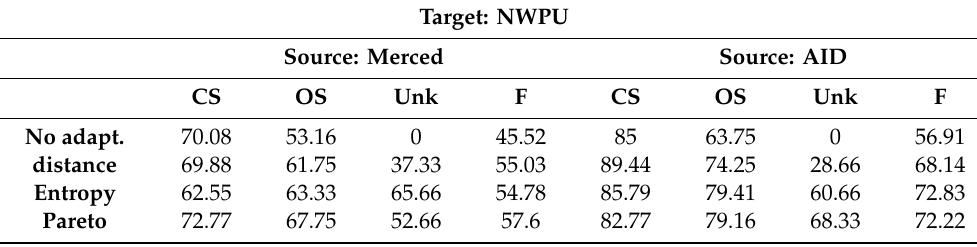
Table 3. Classification results obtained for the scenarios: Merced → NWPU and AID → NWPU for an openness = 25%. Target: NWPU